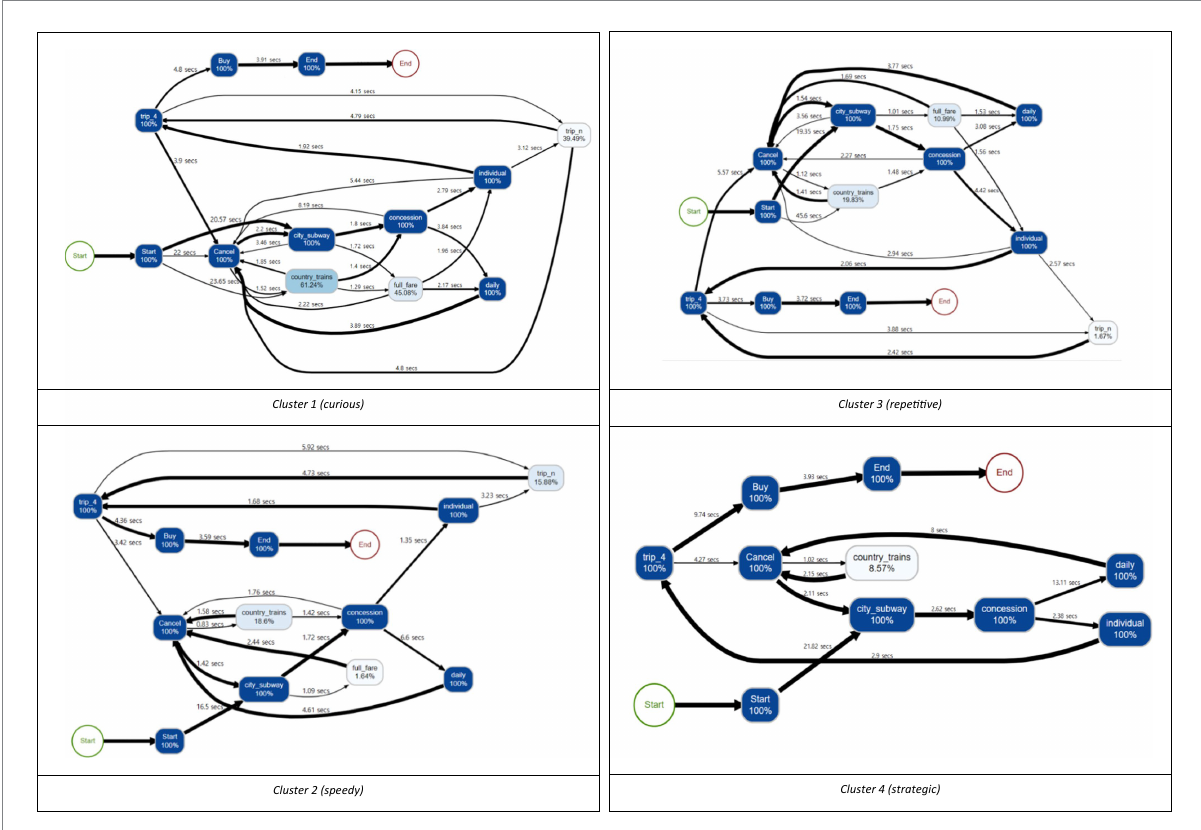
FIGURE 6 Process maps for four clusters for students with the correct